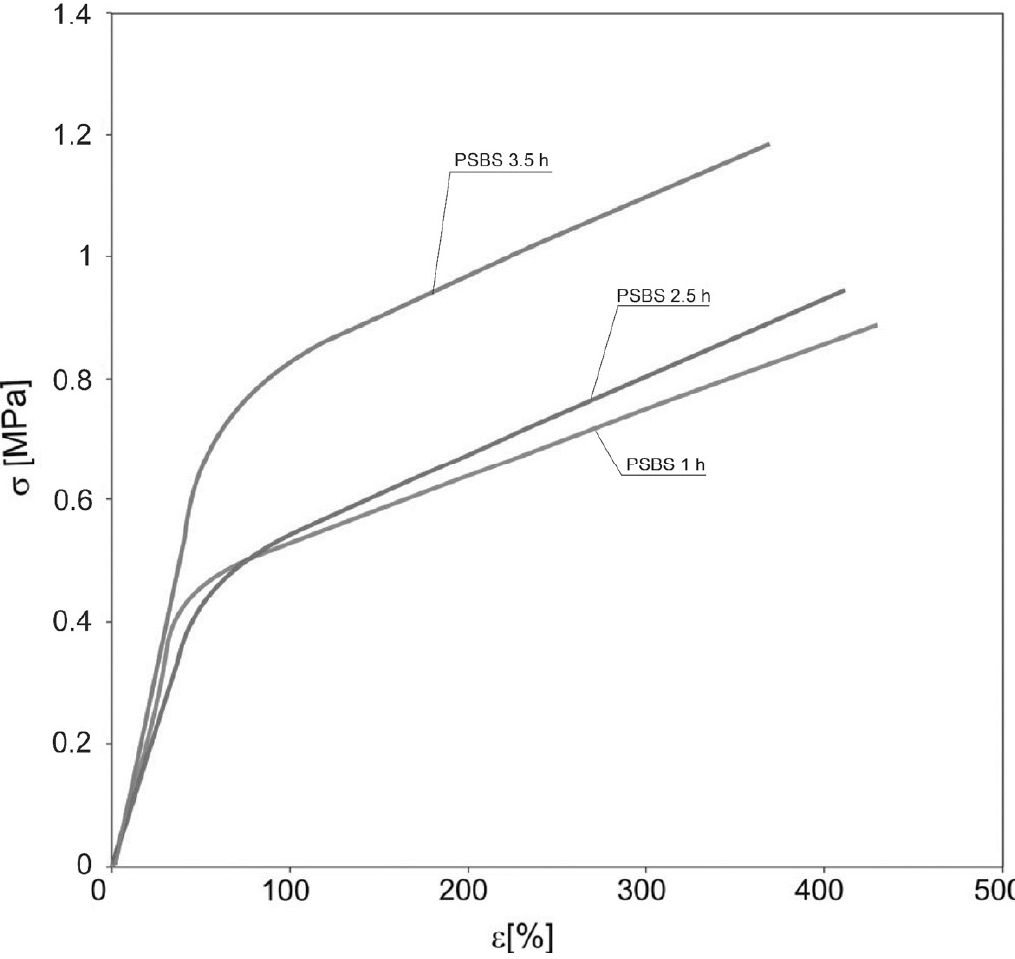
Figure 5. Mechanical properties of PSBS 1 h, PSBS 2.5 h and PSBS 3.5 h .